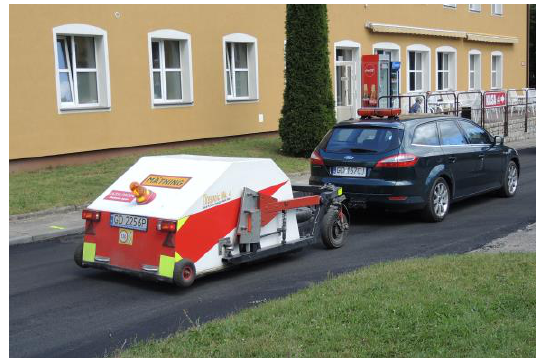
Figure 33. Test trailer Tiresonic Mk.4.